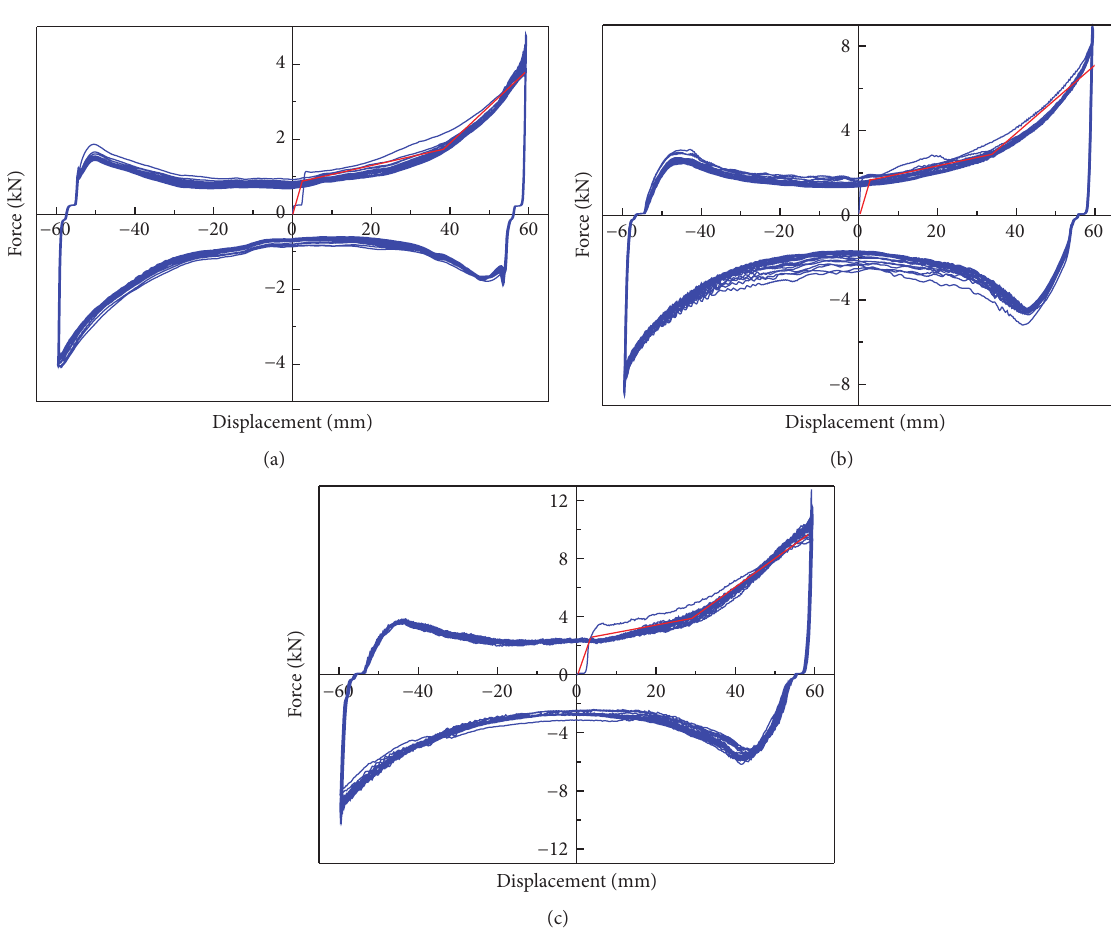
Figure 3: Hysteretic behavior of AFD: (a) Case A, (b) Case B, and (c) Case